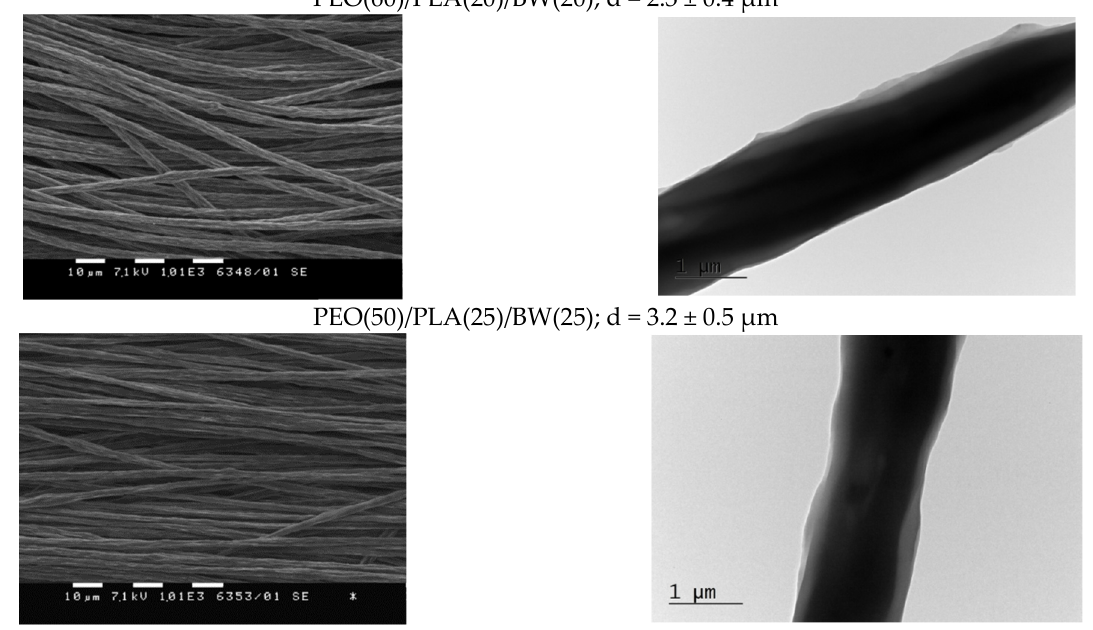
Figure 3. SEM micrographs (magnification: ×1000) of mats and TEM micrographs (magnification: ×5000) of a single fiber of PEO(60)/PLA(20)/BW(20) and PEO(50)/PLA(25)/BW(25) after their 24 h stay in hexane.